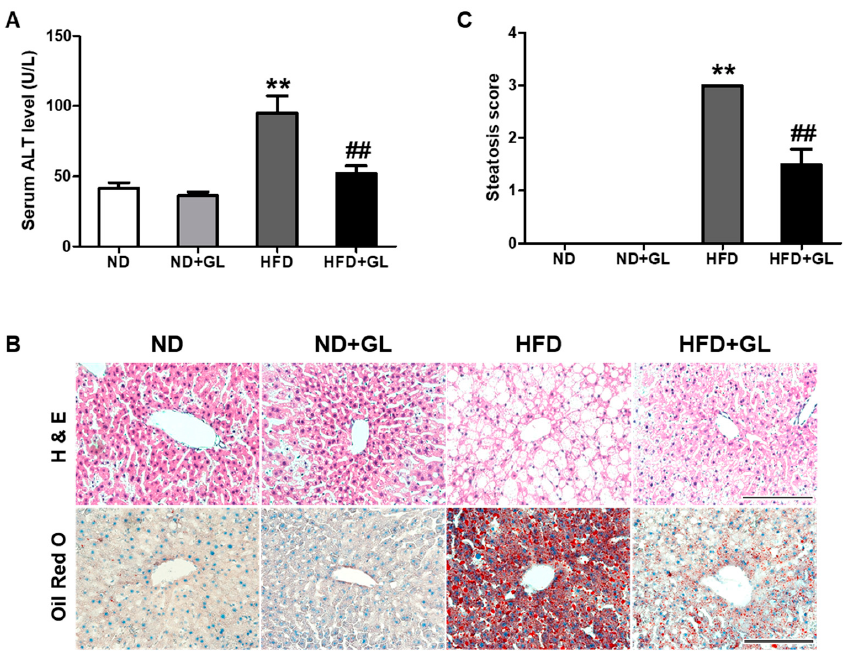
Figure 4. GL attenuated hepatic lipid accumulation and the increase in serum alanine aminotransferase (ALT) level in HFD-fed mice. ( A ) Serum alanine aminotransferase level ( n = 8–9 for each group). ( B ) Representative microphotographs (Scale bar = 100 µ m) of hematoxylin and eosin-stained and